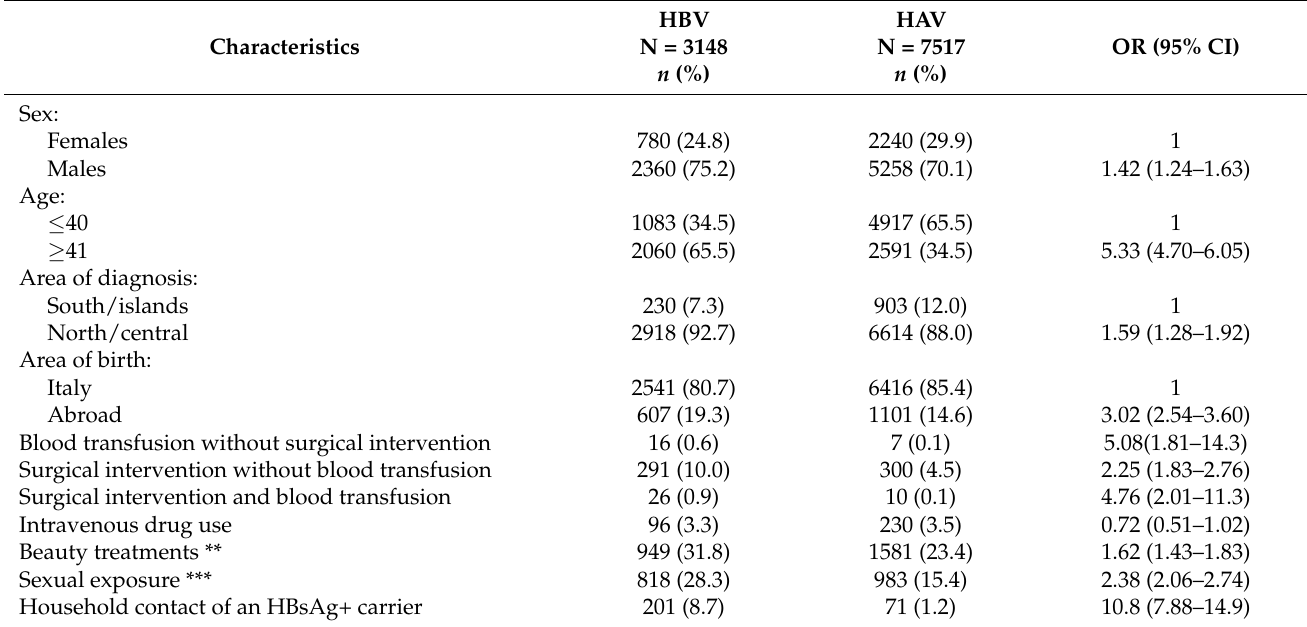
Table 4. Frequency (%) of characteristics reported by acute hepatitis B and acute hepatitis A (control group) cases and adjusted * odds ratio (OR) for the association of acute hepatitis B with characteristics of subjects. SEIEVA